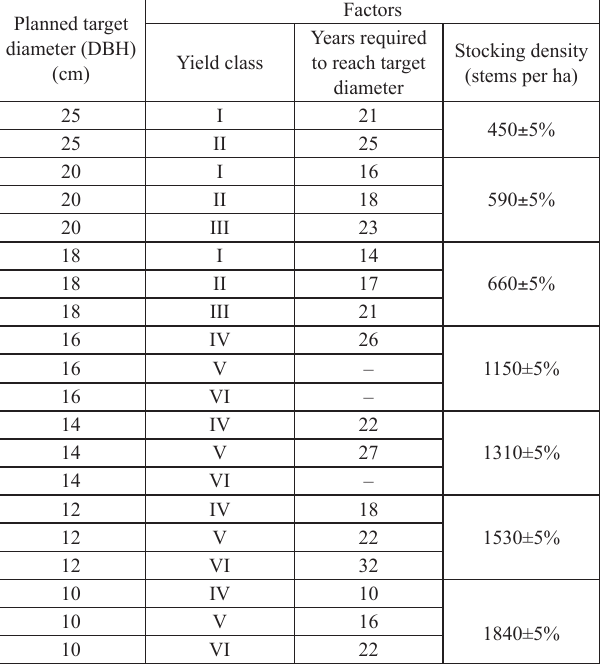
Table 2: Age-target diameter model for black locust stands targeted for quality sawlog production (DBH=18, 20 and 25 cm) and for mass assortments (DBH=10, 12, 14 and 16